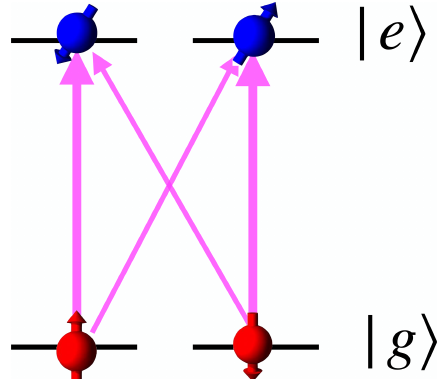
Figure 14. Eigenstates of the nuclear spin in the ground and elec- tronically excited states of a rare-earth ion. The quantization axes (indicated by the direction of the arrows) of ground and excited states have different orientations not along the magnetic field. The pink arrows between the ground and excited states indicate optical transitions, with the widths representing different transition dipole